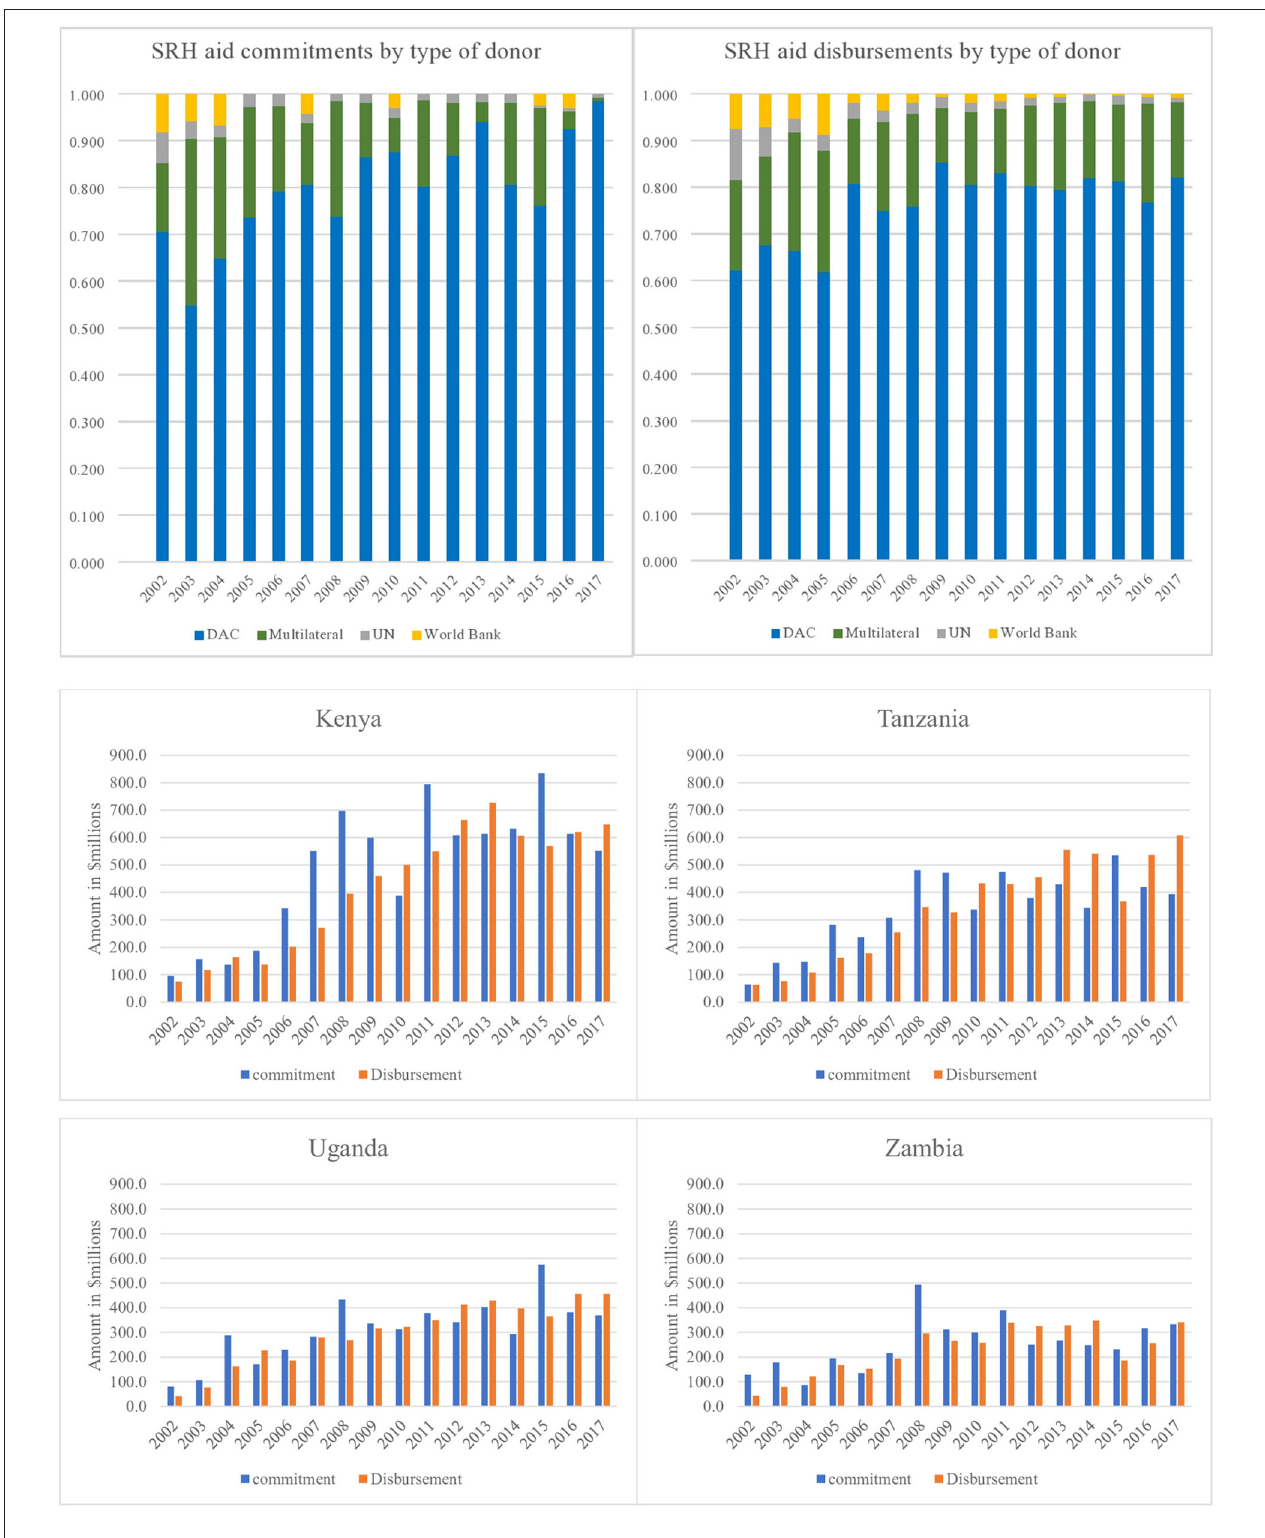
FIGURE 2 | Country specific comparisons in donor aid commitments and disbursements, 2002–2017 (USD millions).